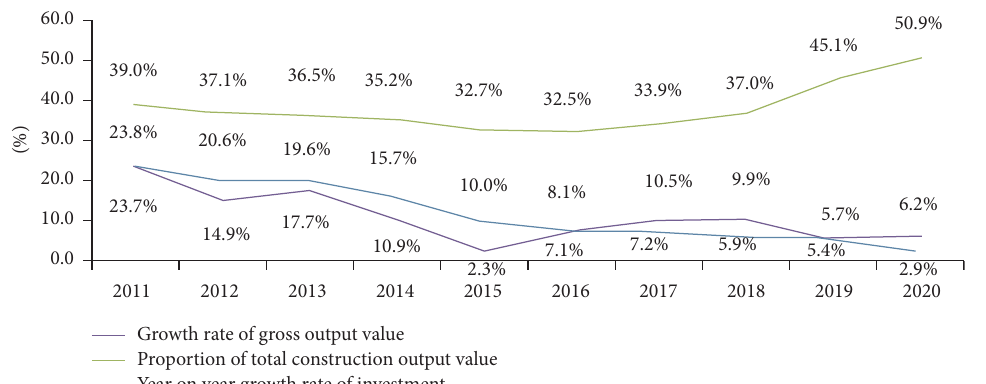
Figure 2: Growth rate of new construction area and completed area. Source: Zhongtai securities research institute, [7].